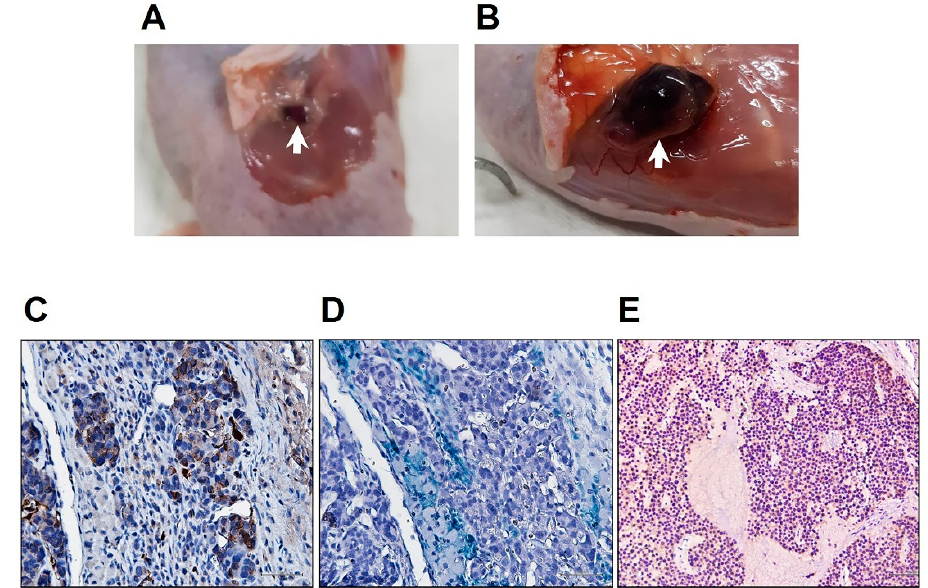
Figure 5. Subcutaneous grafts (indicated by arrows) of hydrogels without ( A , 0.3 × 0.2 × 0.1 cm) or with ( B , 1.3 × 1 × 0.6 cm) MIN6 cells at 65 days after transplantation. The latter graft was stained with insulin ( C , brown) and Prussian blue ( D , blue). ( E ) Insulin staining (brown) of the MIN6 cell graft at 48 days after transplantation.